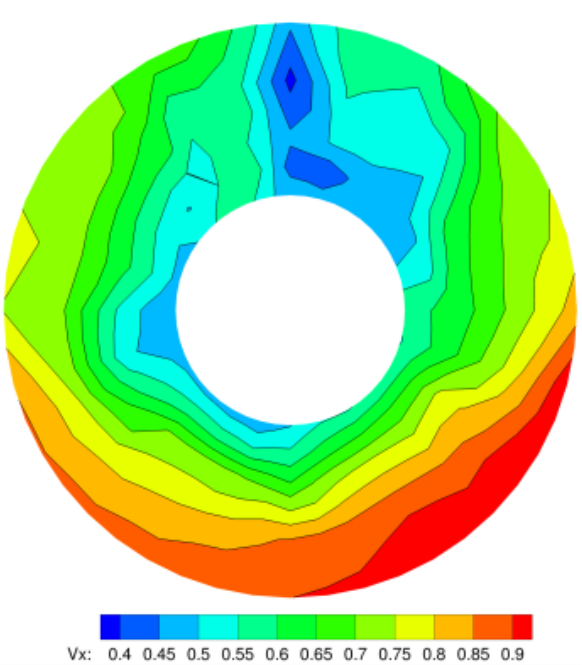
Figure 4: Target wake (left) and obtained wake (right) for cavitation tunnel